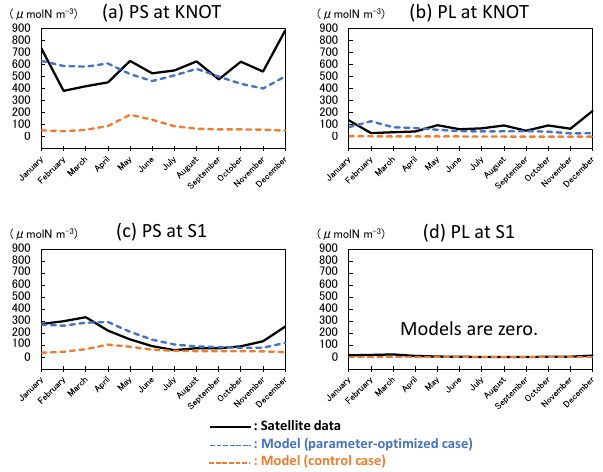
Figure 3. Seasonal variations in surface phytoplankton (PS: small phytoplankton and PL: large phytoplankton) biomass in the 1-D NSI-MEM and satellite data at KNOT and S1 shown as typical ob- servational points of the subarctic and the subtropical regions, re- spectively. (a) PS at KNOT, (b) PL at KNOT, (c) PS at S1, and (d) PL at S1, where the concentrations of the two model cases are al- most zero, and that of the satellite is also remarkably small. The unit conversion between the simulation data (molNm − 3 ) and the satel- lite data (gchl a m − 3 ) is referred to as the nitrogen / chlorophyll ratio of PL = 1:1.59 and PS = 1:0.636 (Shigemitsu et al., 2012). The same conversion of nitrogen to chlorophyll is used in Figs. 4, 6, 8, and